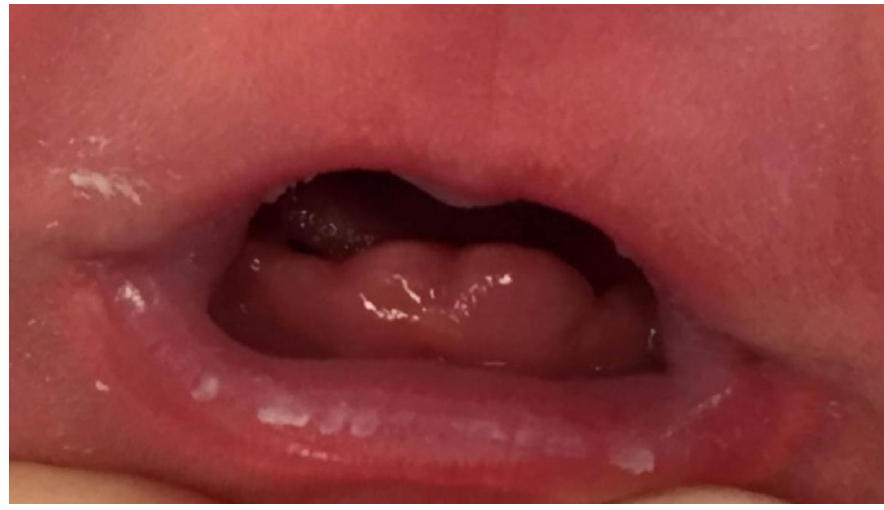
Figure 1. Two-day-old female infant with natal teeth.